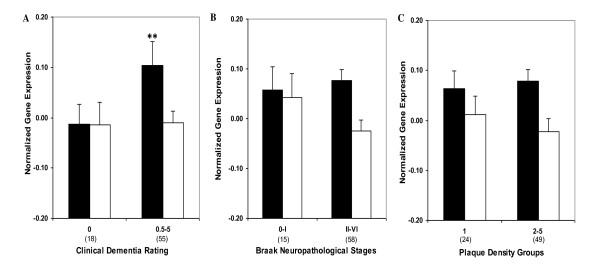
RXRα (Black bars) and LXRβ mRNA (white bars) expression in individuals with and without dementia or AD-associated neuropathology in hippocampus. Mean values ± SEM are shown. **, p < 0.01. Number within the parentheses indicates the individuals within each group.